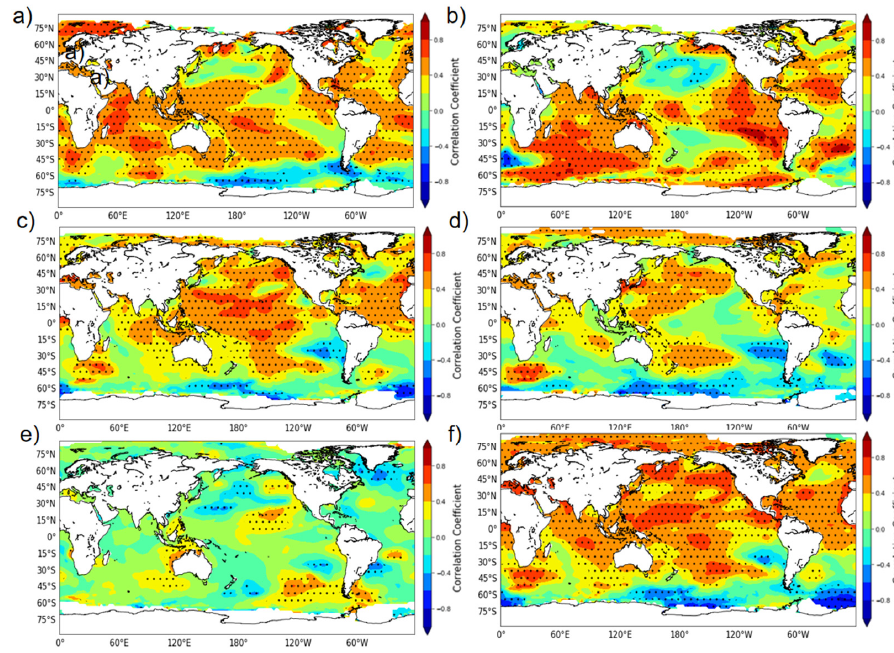
Figure 12. Spatial distribution of the correlation coefficients between the NECVHR and SST during 1961–2019 (shaded). ( a ) May; ( b ) June; ( c ) July; ( d ) August; ( e ) September; and ( f ) average for May–September. The dotted areas indicate the 90% confidence level.